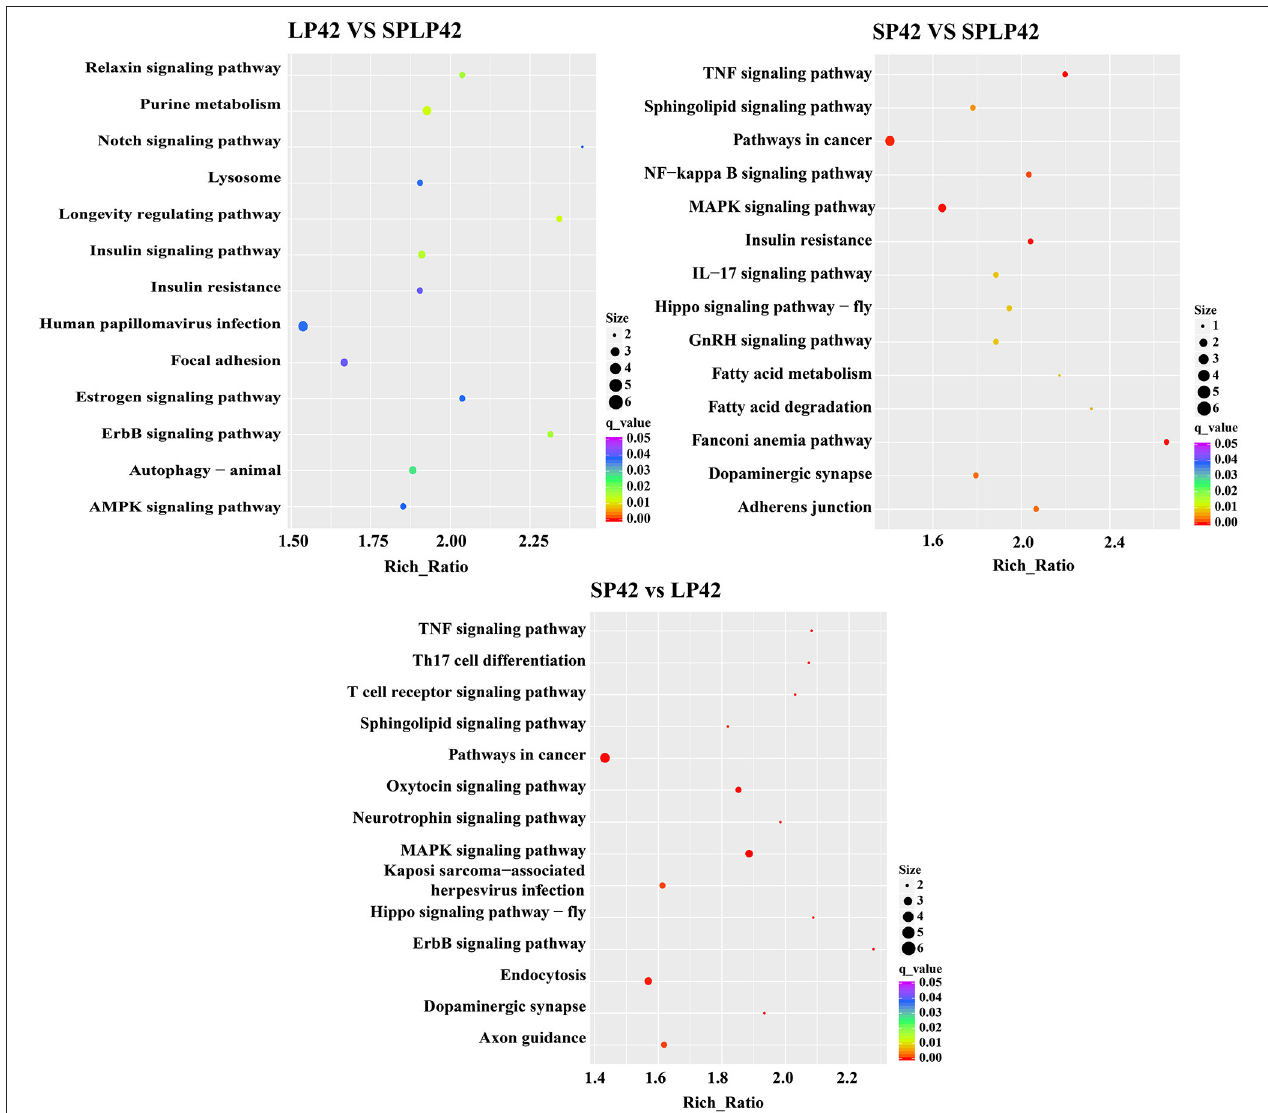
FIGURE 6 | KEGG pathway enrichment analysis of target gene of DELs. The significant enriched KEGG pathways in the three comparison groups of LP42 vs. SPLP42, SP42 vs. LP42 and SP42 vs.